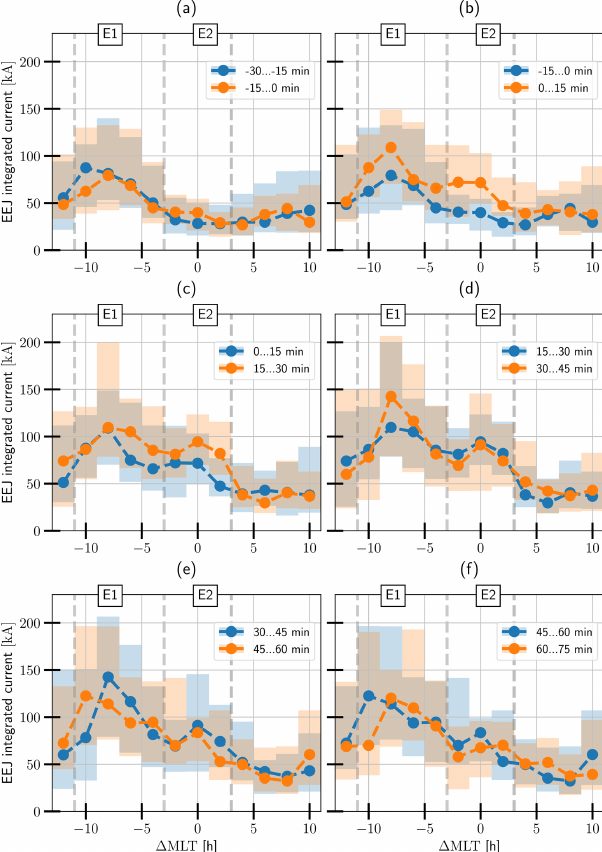
Figure 5. The evolution of the WEJ compared with the previous time step for the time period from 30min before to 75min after the onset. The lines show the medians, and 50% of the values are contained within the bars in each bin.